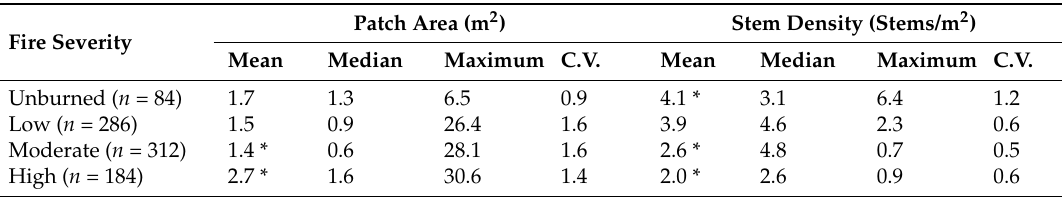
Table 1. Descriptive statistical characteristics of shrub patch structure (patch area and stem density) across fire severity